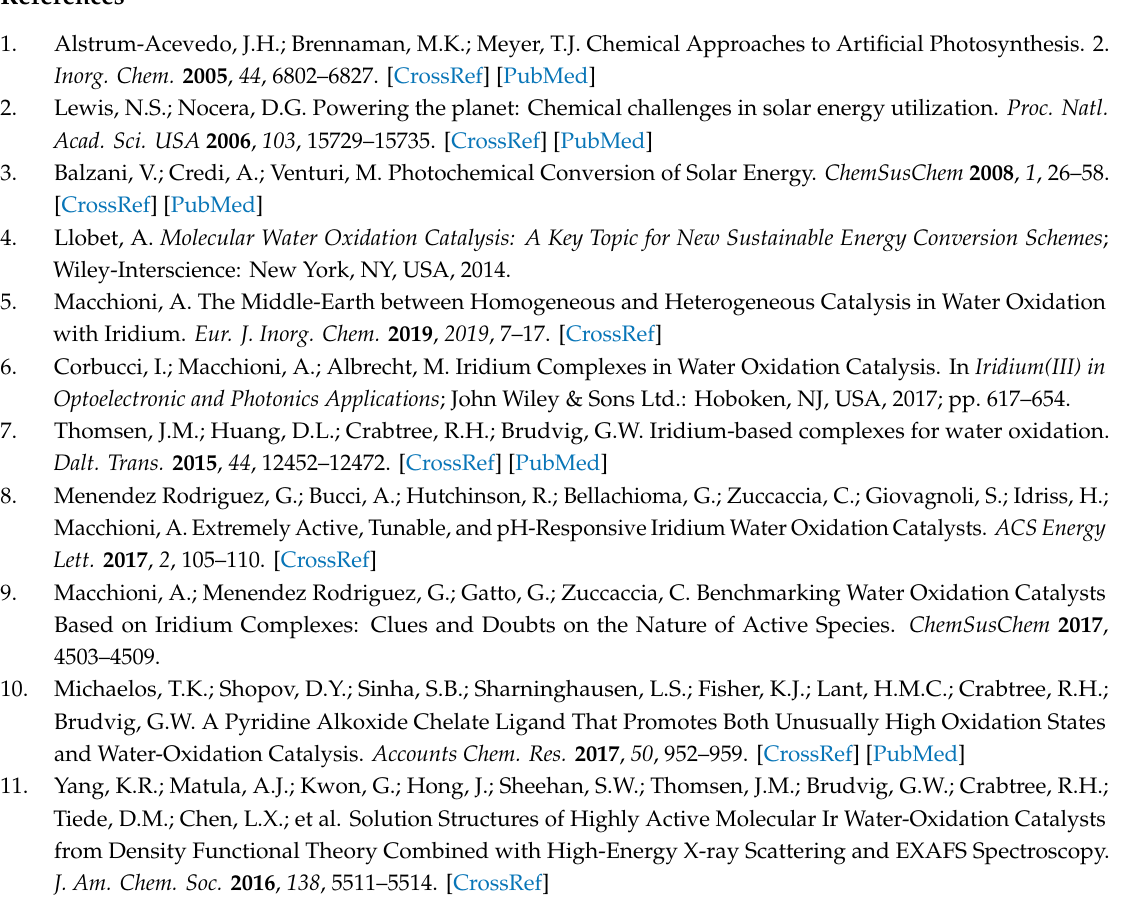
Figure S1: Manometric oxygen evolution of IrEDTA@UiO-66 and UiO-66. Figure S2: Di ff erential manometric oxygen evolution of IrEDTA@UiO-66 and UiO-66. Figure S3: PSDE of FA with IrEDTA complex onto the structure of FA_UiO-66. Figure S4: XRPD patterns of IrEDTA@UiO-66(3) before and after three catalytic runs. Figure S5: 1 H-NMR spectrum of IrEDTA@UiO-66 after 3 catalytic